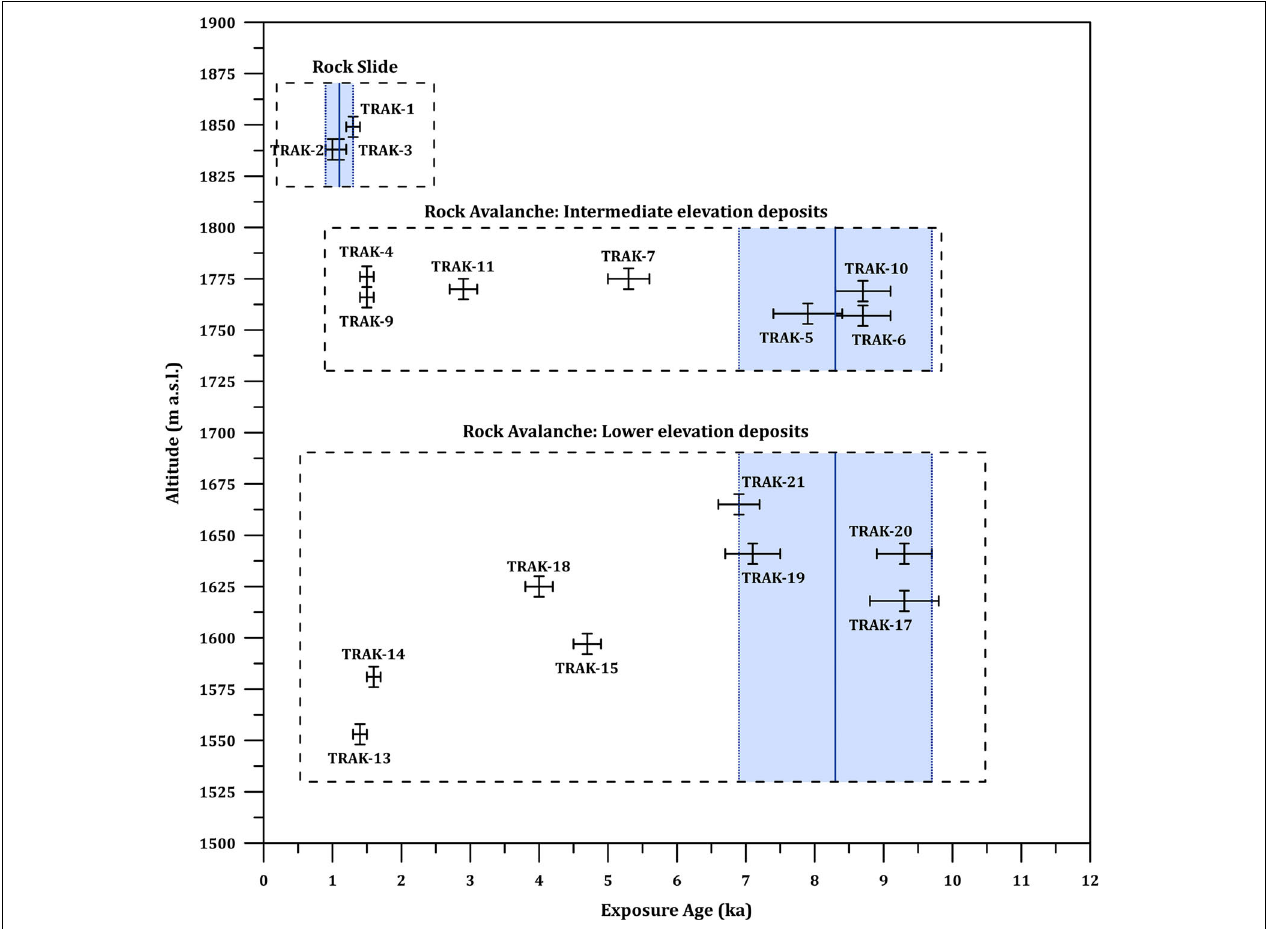
FIGURE 8 | Altitude versus cosmogenic 36 Cl exposure age plot. Plotted uncertainties are one sigma. Dark blue solid line indicates weighted mean ages of the rock avalanche and rockslide. Blue shaded area shows the two sigma solution space.